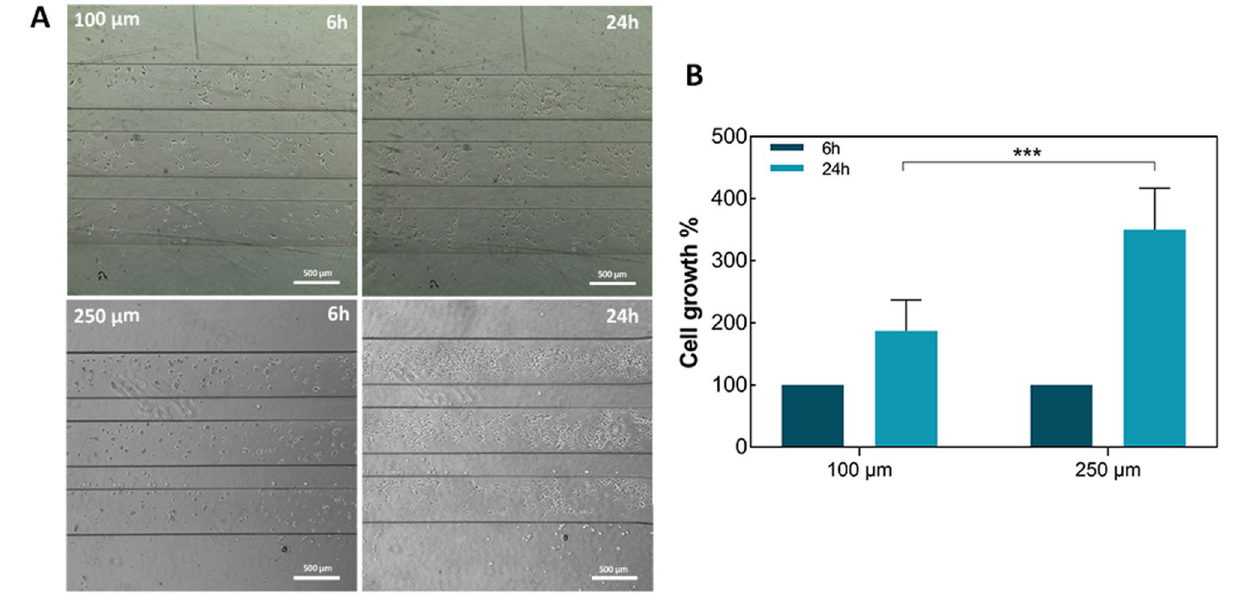
Figure 3. Effects of different channel heights on cell growth. ( A ) Phase contrast microscope images of SH-SY5Y grown on microfluidic device having 100 μm and 250 μm channels at 6 h and 24 h. Scale bar: 500 μm. (B ) Bar graph representation of SH-SY5Y cell at 6 and 24 h, following normalization to cell count measured at 6 h. Histogram bars represent the average of 4 experiments and error bars indicate the standard deviation (Two-way ANOVA test: *** p <